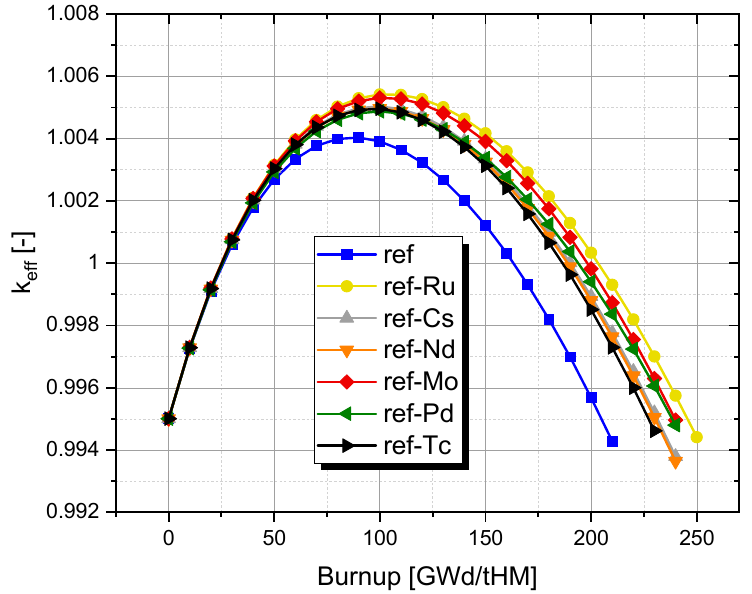
Figure 4. Effect on criticality caused by cleaning 5% of different fission product elements with the strongest influence on criticality, based on a simulation using 10 GWd/tHM steps for the scripted calculation.